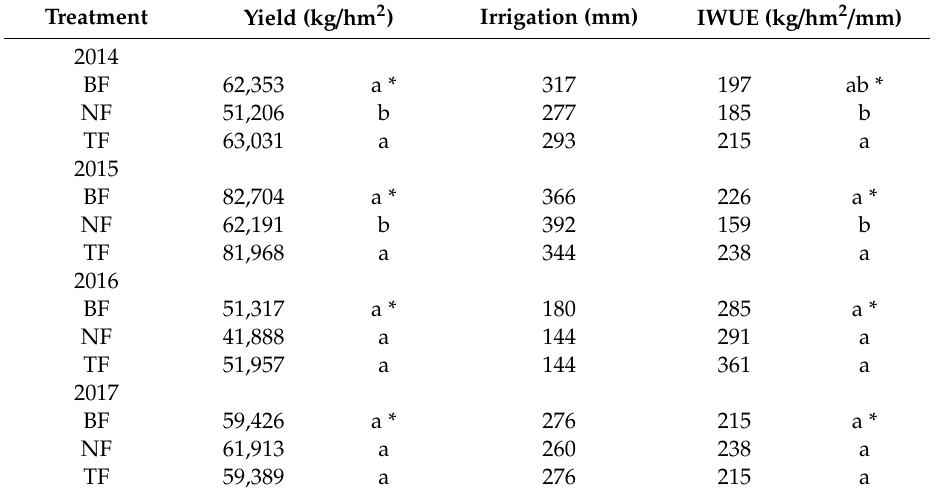
Table 7. Potato tuber yield, irrigation, and irrigation water use e ffi ciency (IWUE) of black film (BF), no film (NF), and transparent film (TF) treatment in